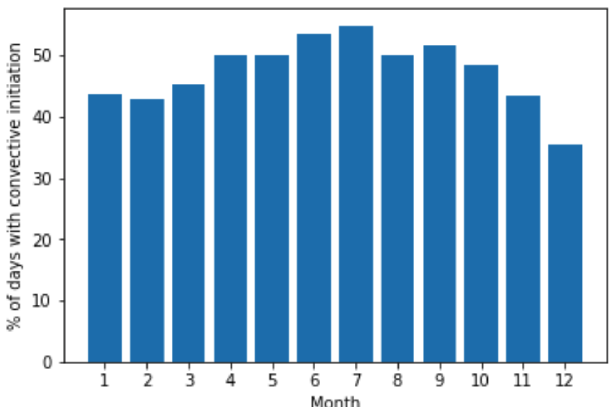
Figure 11. Monthly percentage of days during 2015–2017 with at least one isolated cell initiation within a 200km range of the KHGX radar.